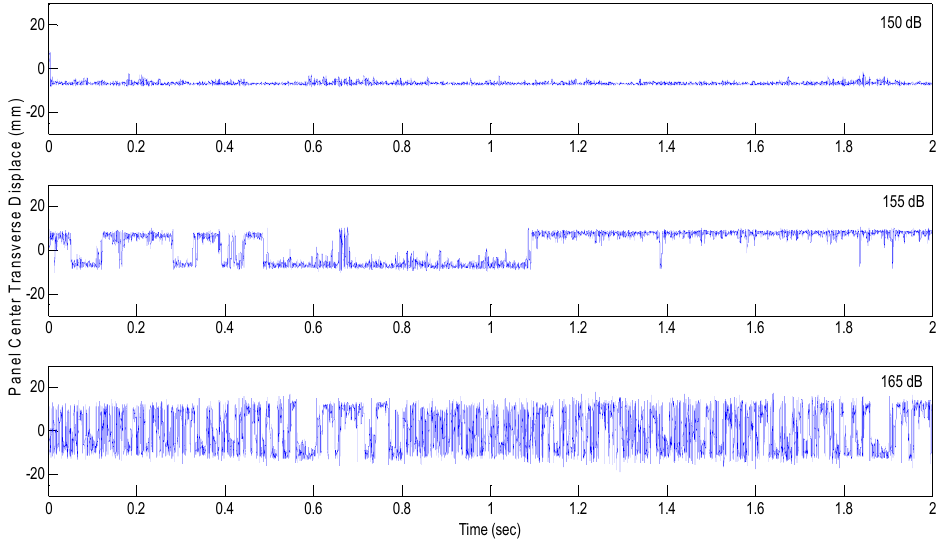
Figure 4. Transverse displacement response at the center of the thermally post-bucked panel at 600 °C.